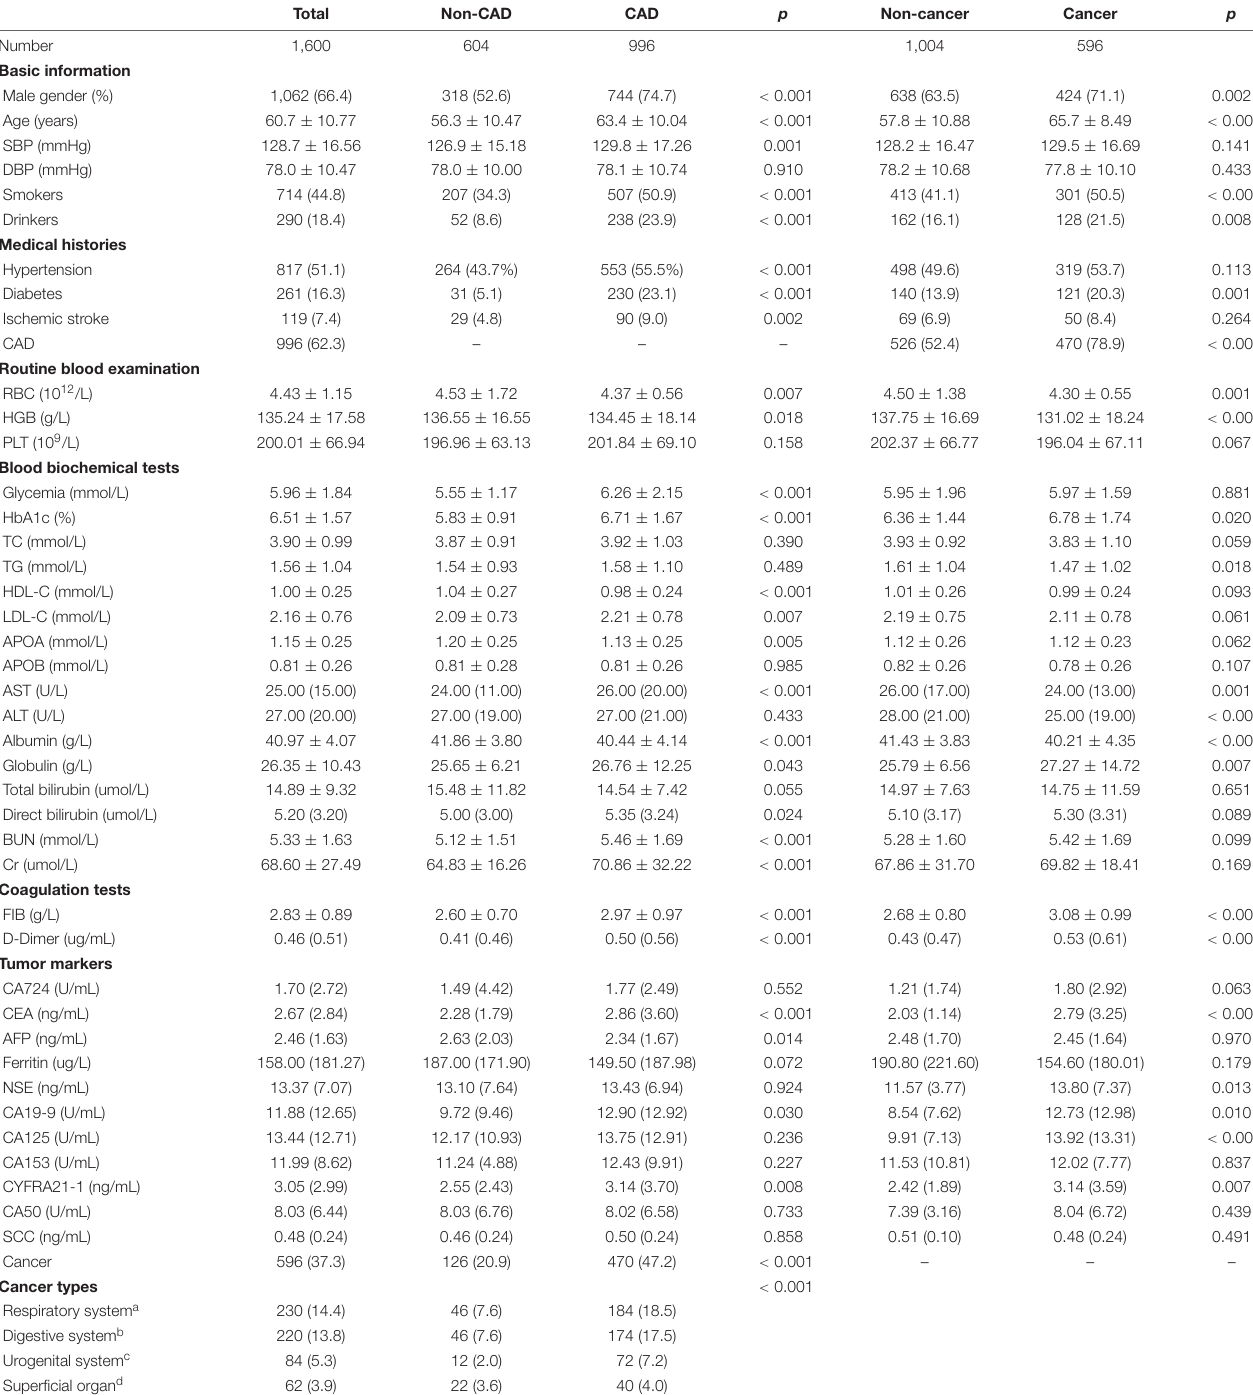
TABLE 1 | Baseline characteristics of patients with/without CAD and with/without